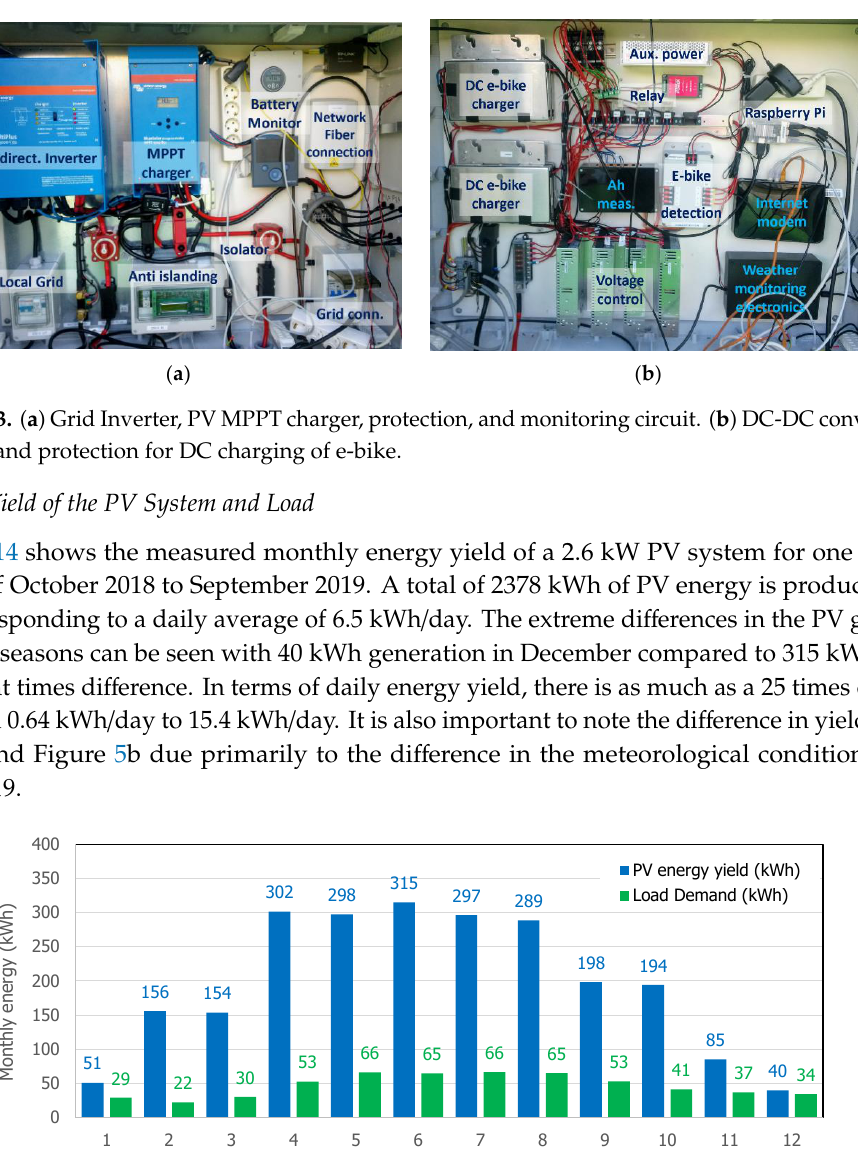
Figure 13. ( a ) Grid Inverter, PV MPPT charger, protection, and monitoring circuit. ( b ) DC-DC